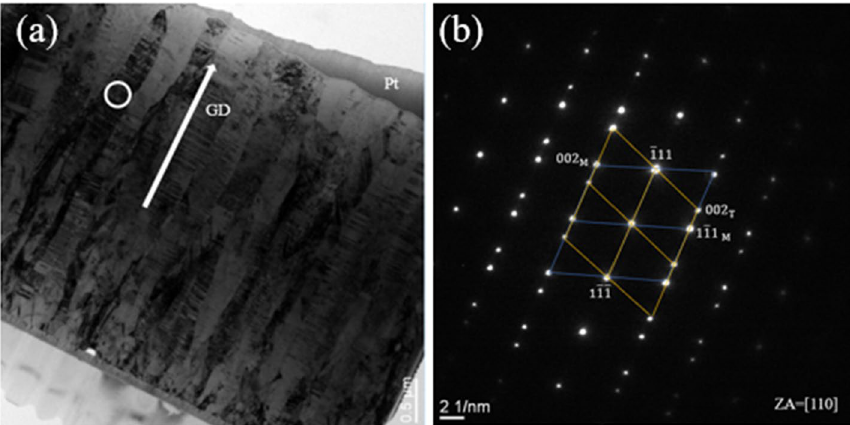
Figure 2. ( a ) Cross-sectional bright field TEM image of sputtered Cu nanotwins and ( b ) selected area electron diffraction (SAD) pattern obtained from the white circle in ( a ).